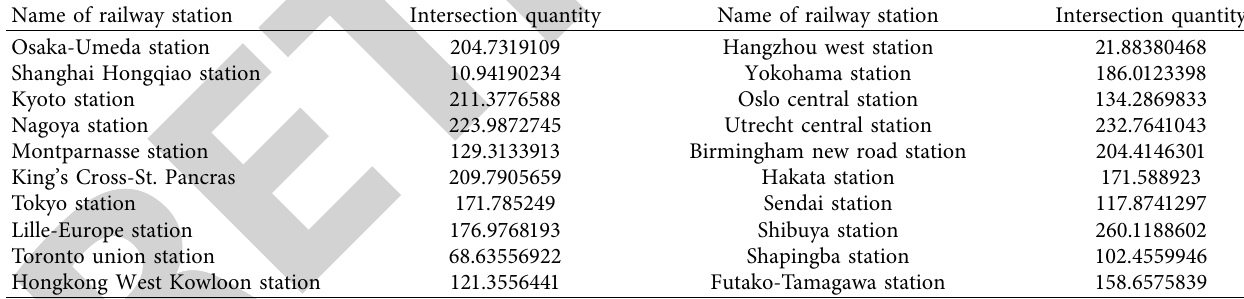
Figure 4: The road network structure. Table 3: Data of intersection quantity of road networks obtained from the BaiduMap